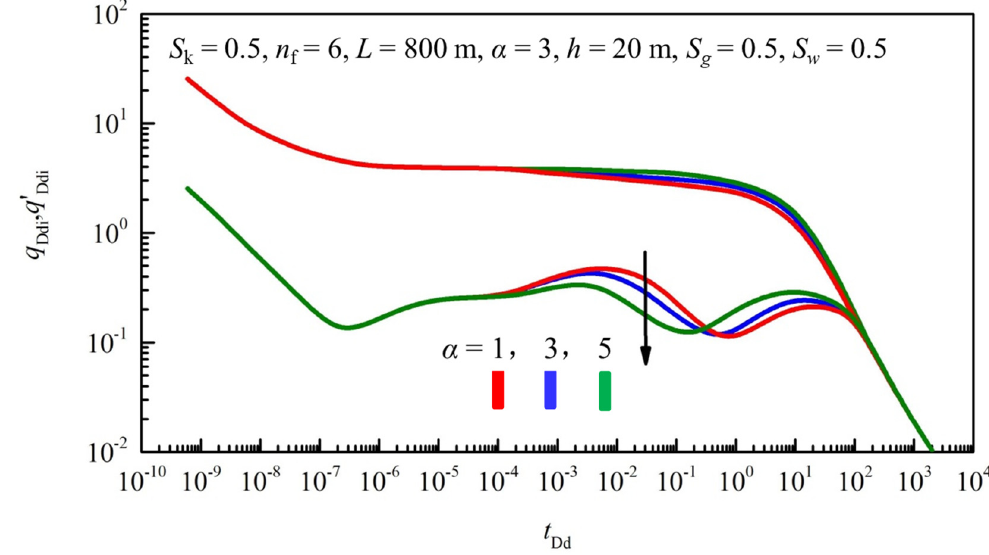
Figure 7. Effect of desorption coefficient on dimensionless production integrals and derivative curve.